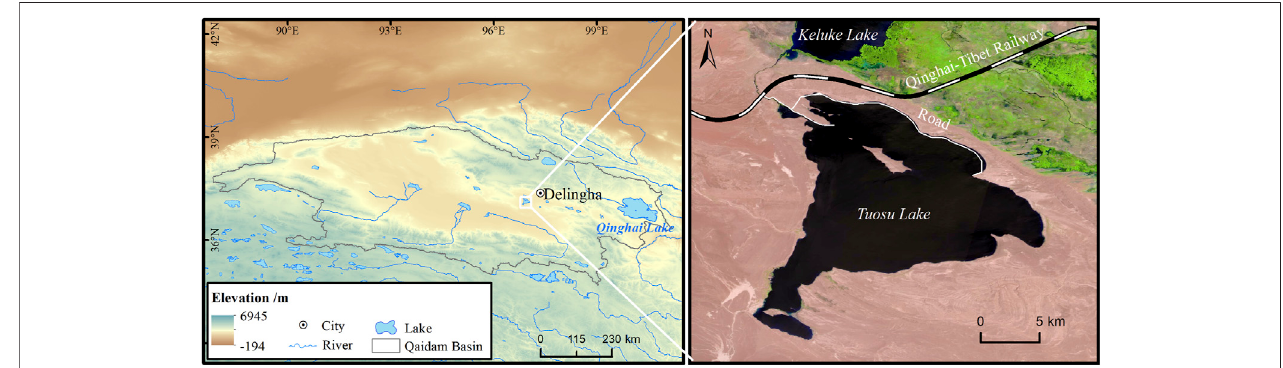
FIGURE 1 | Overview of Tuosu Lake (the right is the Sentienl-2B MSI image acquired on 22 July 2021).